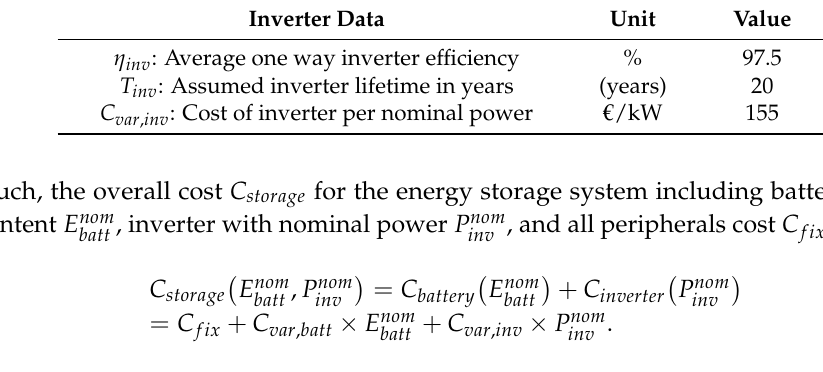
Table 3. Inverter performance and price information derived from literature survey [15,31]. Inverter Data